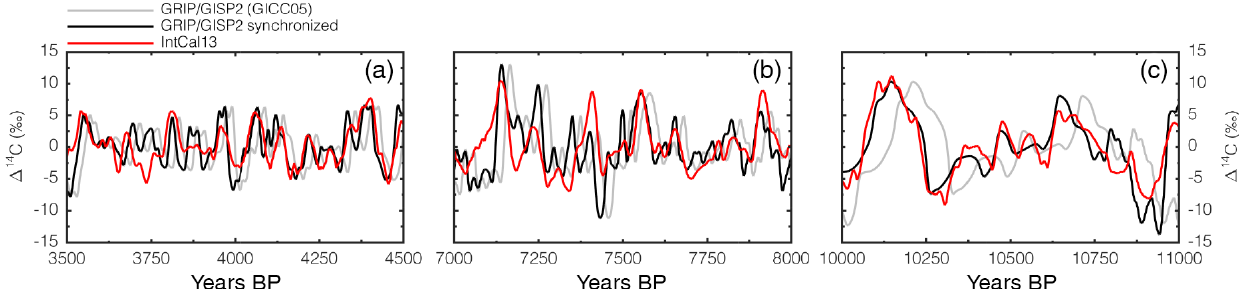
Figure 10. GRIP/GISP2 10 Be based (cid:49) 14 C before (grey) and after (black) synchronization to IntCal13 (red) for the sections (a) 3500–